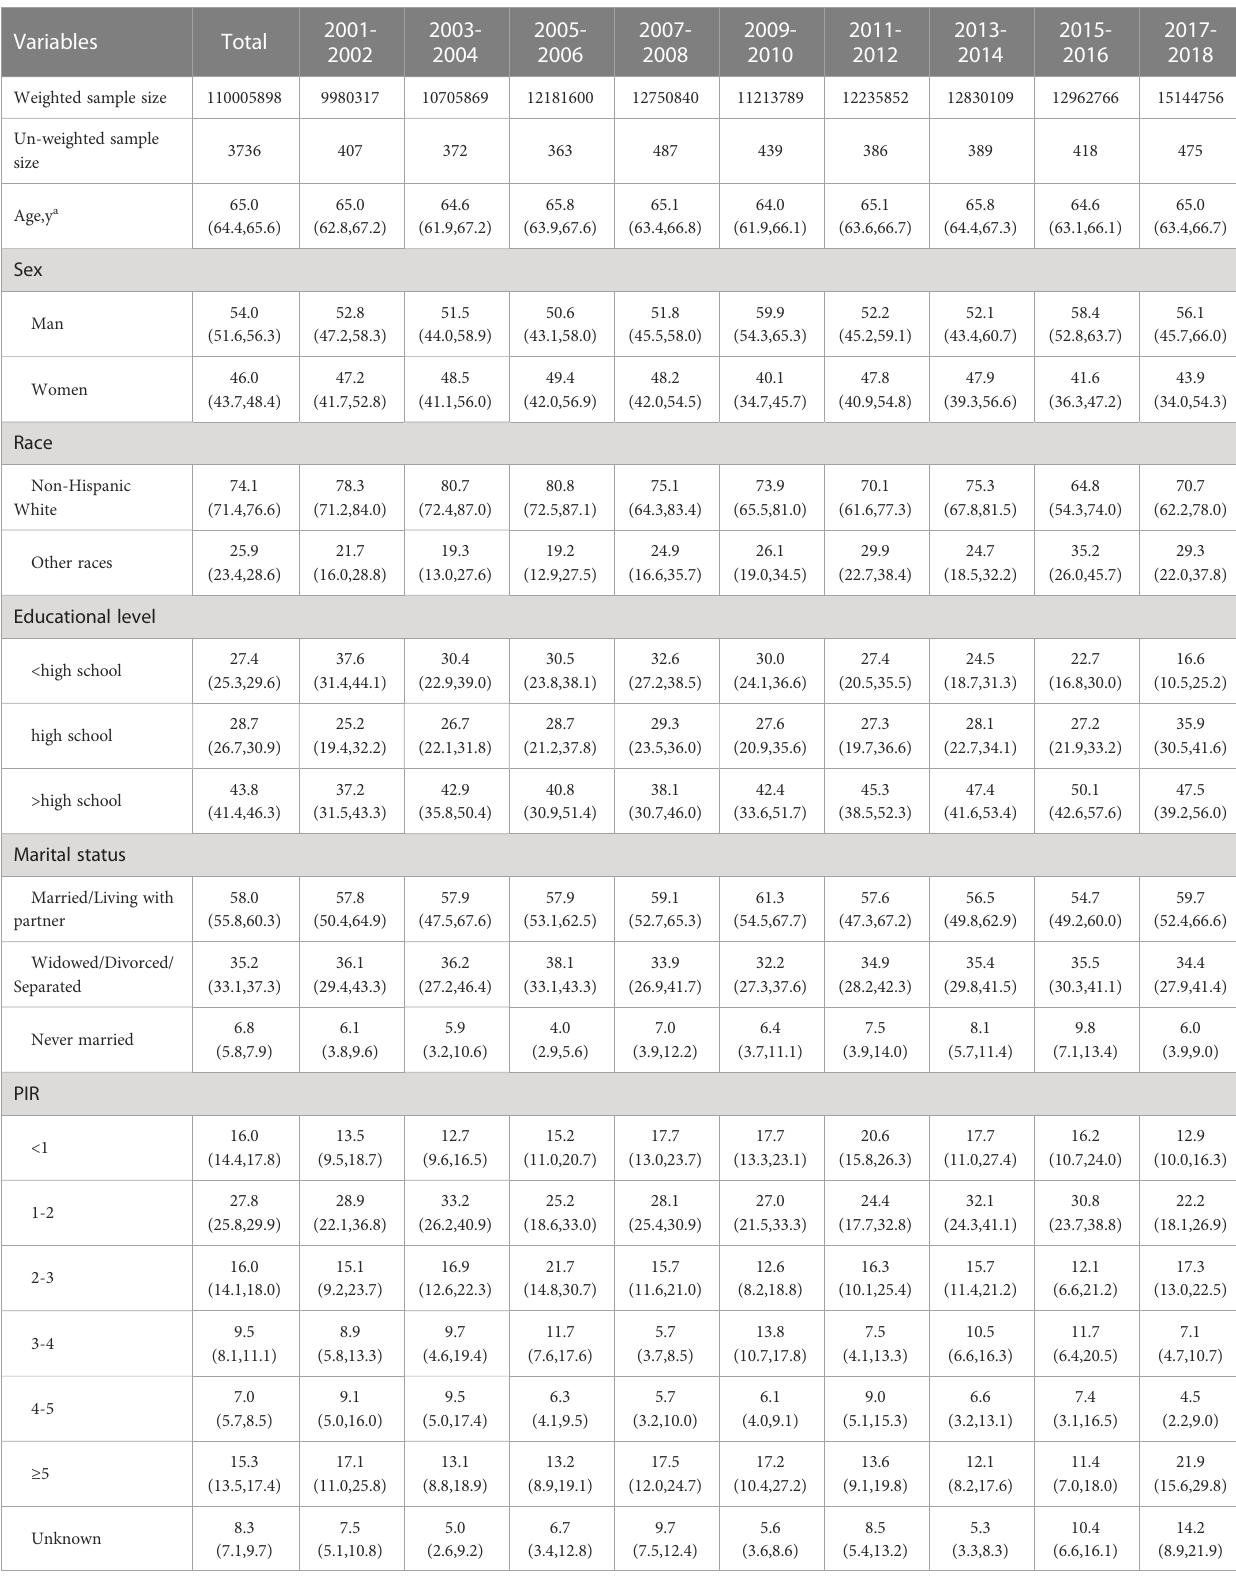
TABLE 1 Baseline of characteristic of all surviviors of stroke and or myocardial infarction from 2001-2018, weighted.